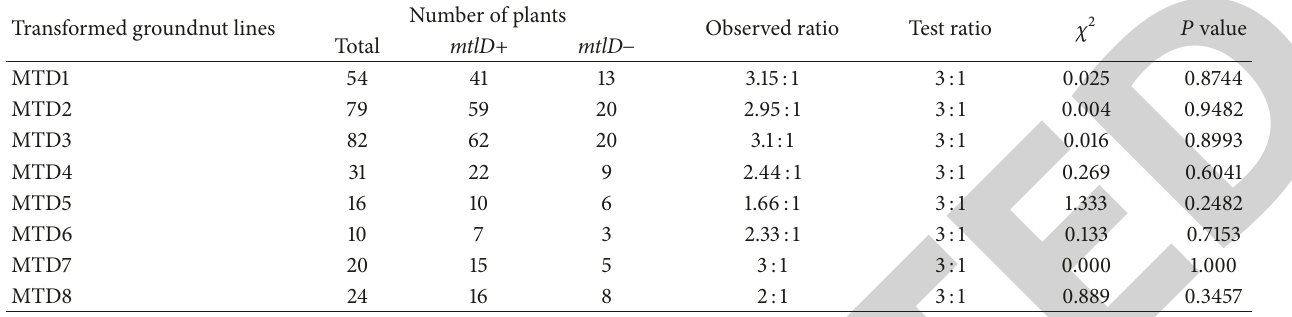
) derived from mtl D transgenic peanut plants. 1